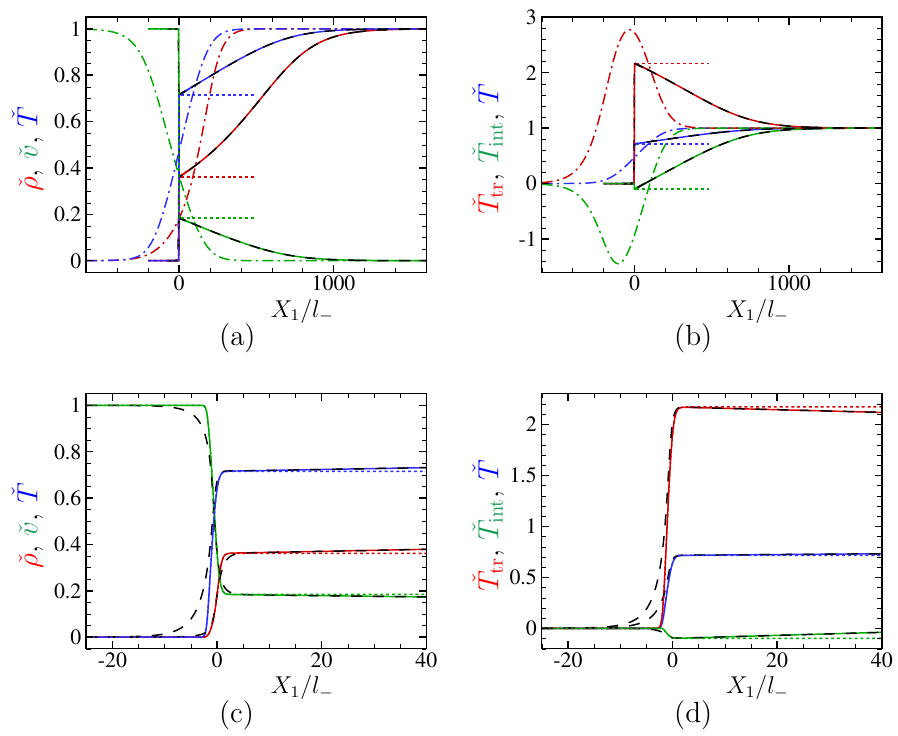
Figure 8. Profiles of ˇ ρ , ˇ v , ˇ T , ˇ T tr , and ˇ T int in the case of the pseudo-CO 2 gas at M − = 5 for µ b / µ = 1000. ( a , c ) ˇ ρ , ˇ v , and ˇ T ; ( b , d ) ˇ T tr , ˇ T int , and ˇ T . See the caption of Figure